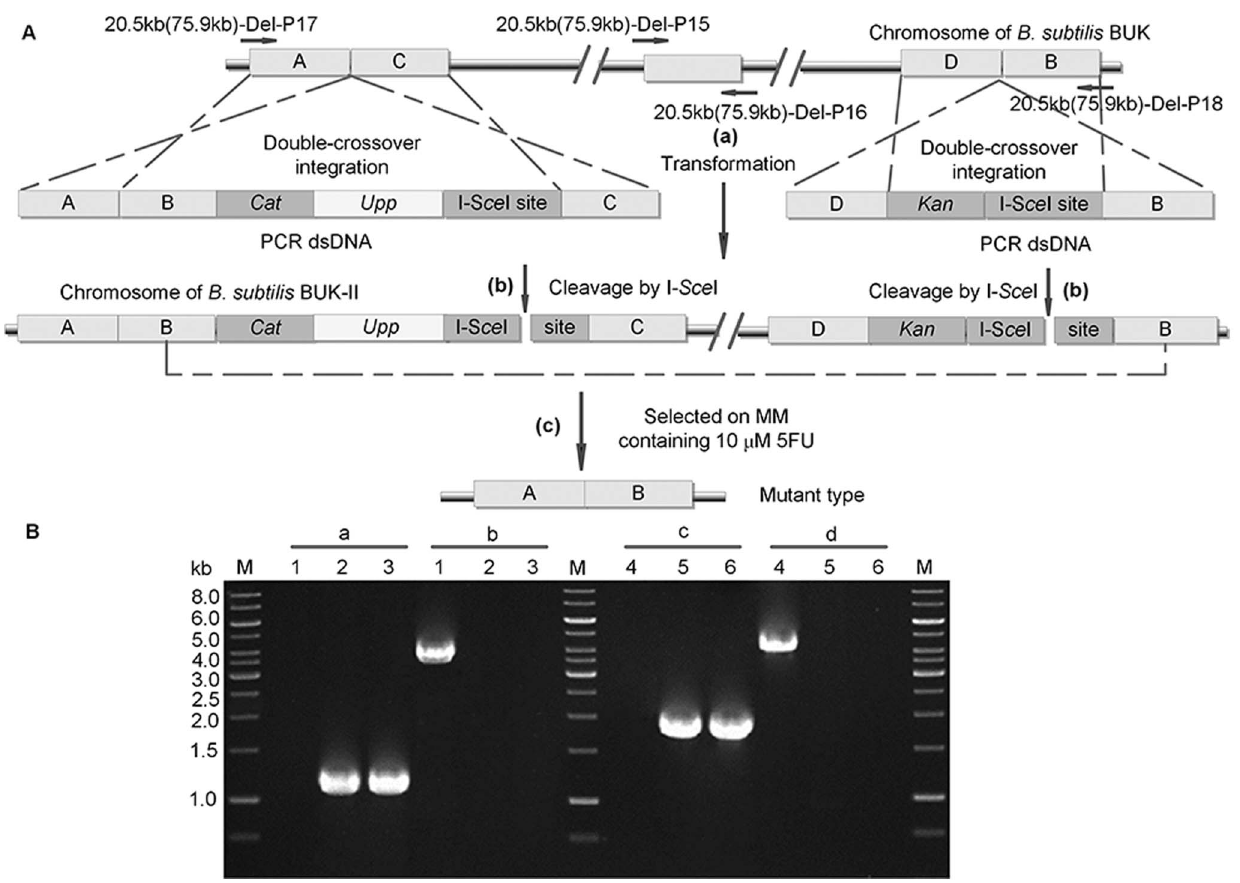
Figure 5. Markerless deletion of large chromosomal regions stimulated by DSB. A. (a) Two dsDNA fragments were generated by fusion PCR and integrated into genome by double-crossover events. (b) The endonuclease I-S ce I was expressed from pEBS- cop 1 under the induction of xylose, and the genome of B. subtlis BUK-II was subjected to I-S ce I cleavage. (c) Deletion mutants were isolated on MM plate containing 10 m M 5FU and confirmed by PCR. A, B, C, D represent DNA segments selected for homologous recombination. B. Verification of the 20.5 kb and 75.9 kb deletions in BUK by PCR. Fragments were amplified using the primer pairs 20.5 kb-DEL-P15/20.5 kb-DEL-P16 (a), 20.5 kb-DEL-P17/20.5 kb-DEL-P18 (b), 75.9 kb-DEL-P15/75.9 kb-DEL-P16 (c), 75.9 kb-DEL-P17/75.9 kb-DEL-P18 (d). 1 kb DNA Ladder (Fermentas) was used as a molecular weight marker (lane M). (a) Amplification of the ydcR gene (534334–535389 SubtiList coordinates) in the 20.5 kb DNA region of B . subtilis ; (b) Amplification of the 20.5 kb DNA fragment of B. subtilis ; (c–d) Confirmation of the 75.9 kb deletion of BUK was the same as that of 20.5 kb deletion. Amplification of the pksG gene (1789763–1791405 SubtiList coordinates) in the 75.9 kb DNA region of B . subtilis (c) and amplification of the 75.9 kb DNA fragment of B. subtilis (d). Each lane showed amplified DNA generated from a DNA template: lane 1, BUK D 20.5 kb; lane 2, BUK-II (20.5); lane 3, BUK; lane 4,